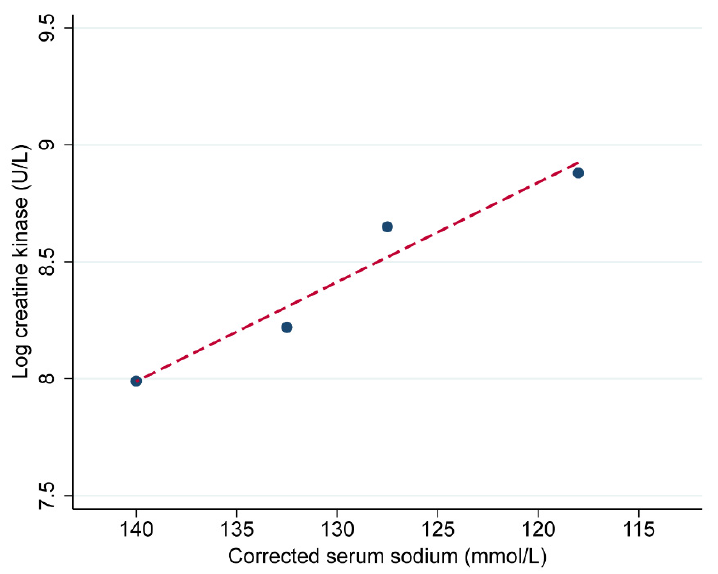
Figure 4. Plot of the mean log creatine kinase versus the mid-point of sodium categories, and fitted with least-squares linear regression line, demonstrating a linear trend for increasing creatine kinase moving normal sodium concentration to severe hyponatremia. Note: scale is reversed on the x-axis, with sodium decreasing from left to right.